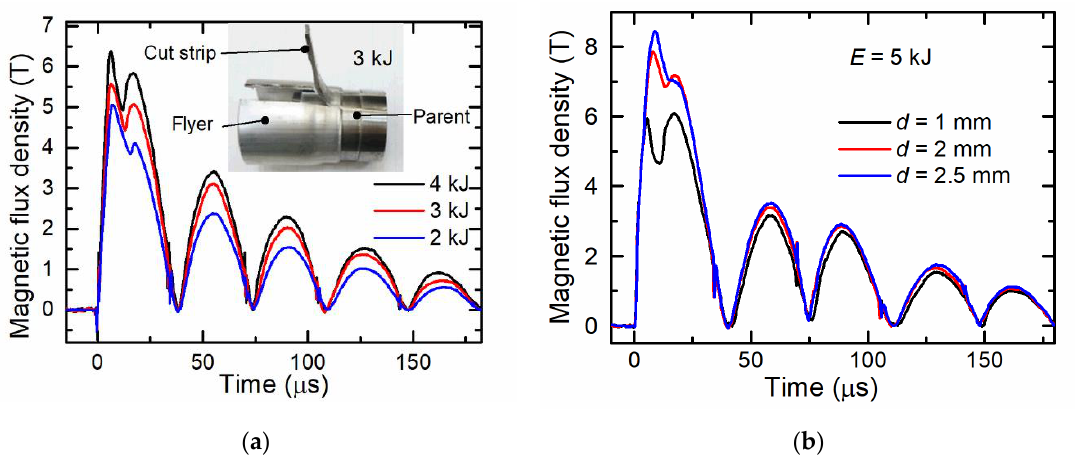
Figure 3. Magnetic fields between the field shaper and the aluminum flyer tube at different charging energies when tube wall thickness is d = 1.5 mm, the joining gap is h = 1.5 mm ( a ) and the charging energy is 5 kJ, also when the wall thicknesses are d = 1, 2, 2.5 mm ( b ).